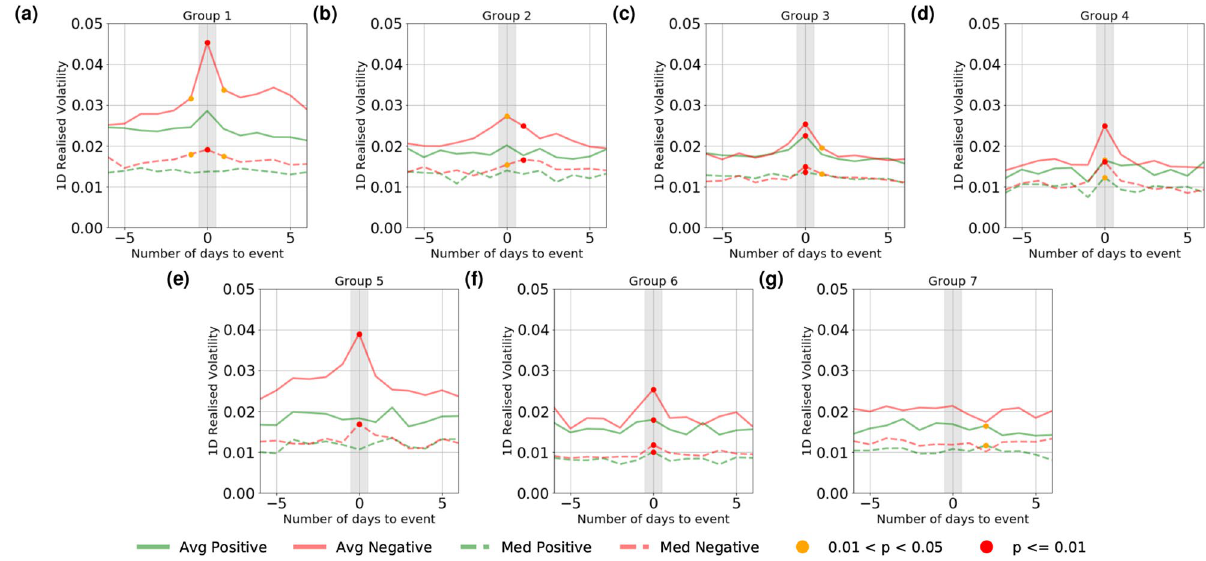
Figure 4. Change in mean and median daily volatility of the companies experiencing sentiment events, computed over all events over the time period and averaged over each company group.